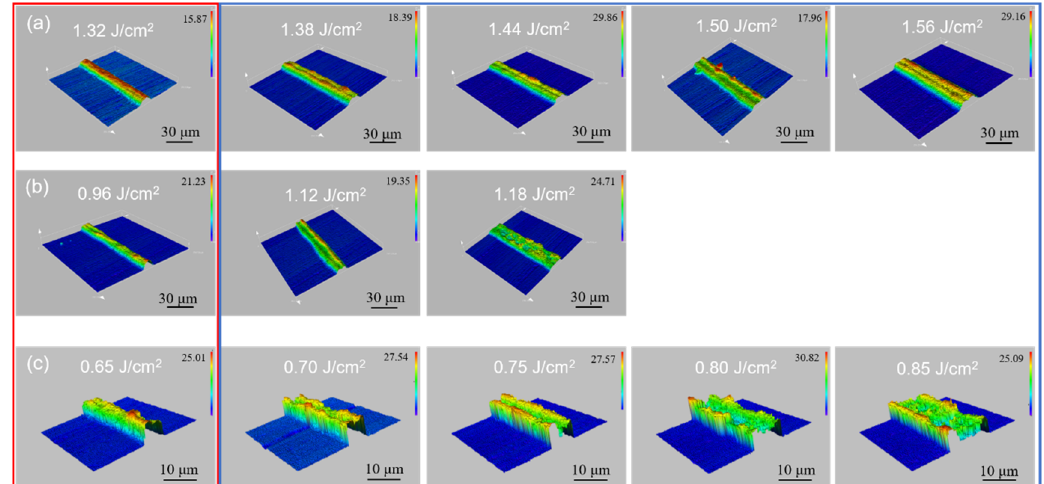
Figure 5. Three-dimensional morphology of the formed lines under different laser fluences and processing speeds obtained by LSCM. ( a ) 1.32–1.56 J/cm 2 , 5000 mm/s, ( b ) 0.96–1.18 J/cm 2 , 2500 mm/s, ( c ) 0.65–0.85 J/cm 2 , 1000 mm/s.